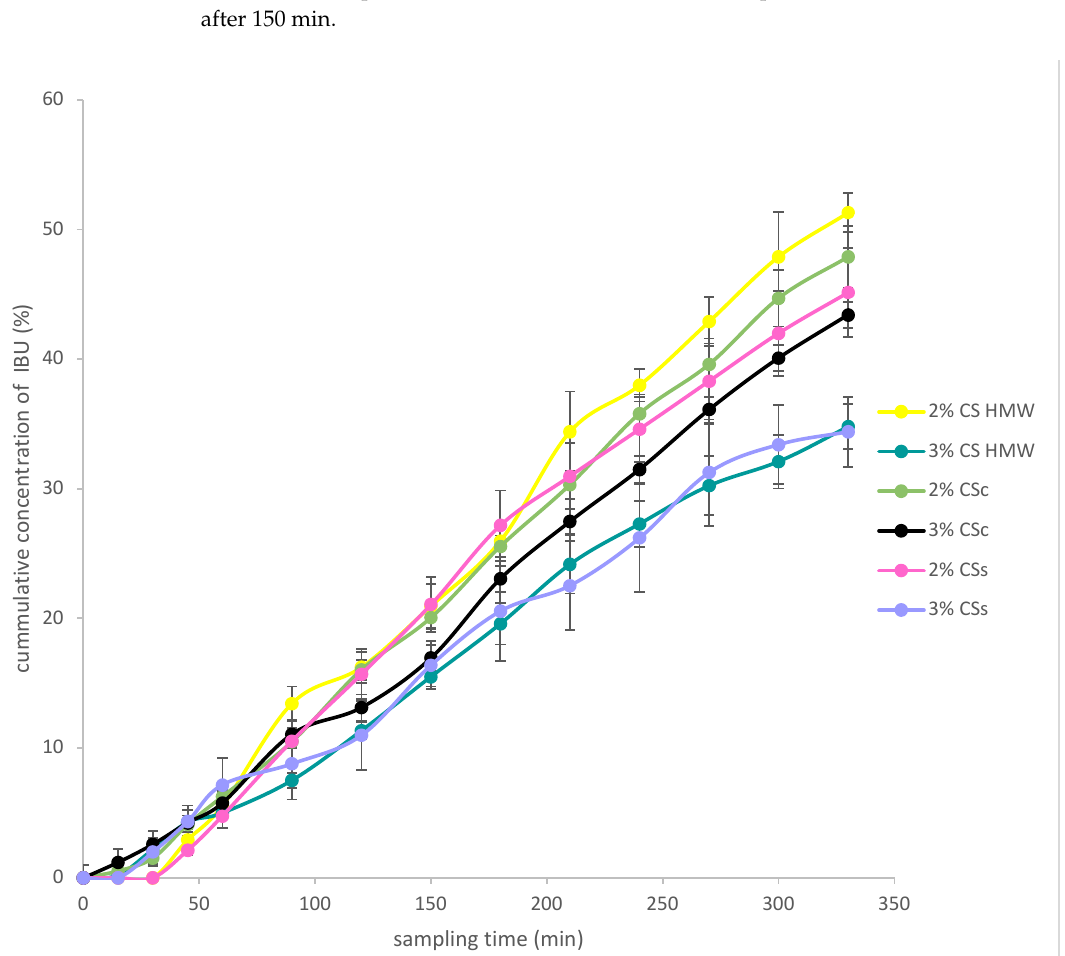
Figure A3. Comparison of the cumulative amount of ibuprofen (%) released from chosen hydrogels after 150 min.